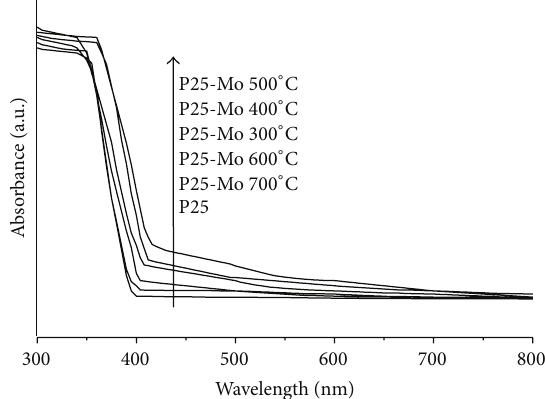
Figure 3: XPS spectra of Mo element. Table 1: The atomic content of Mo-P25.